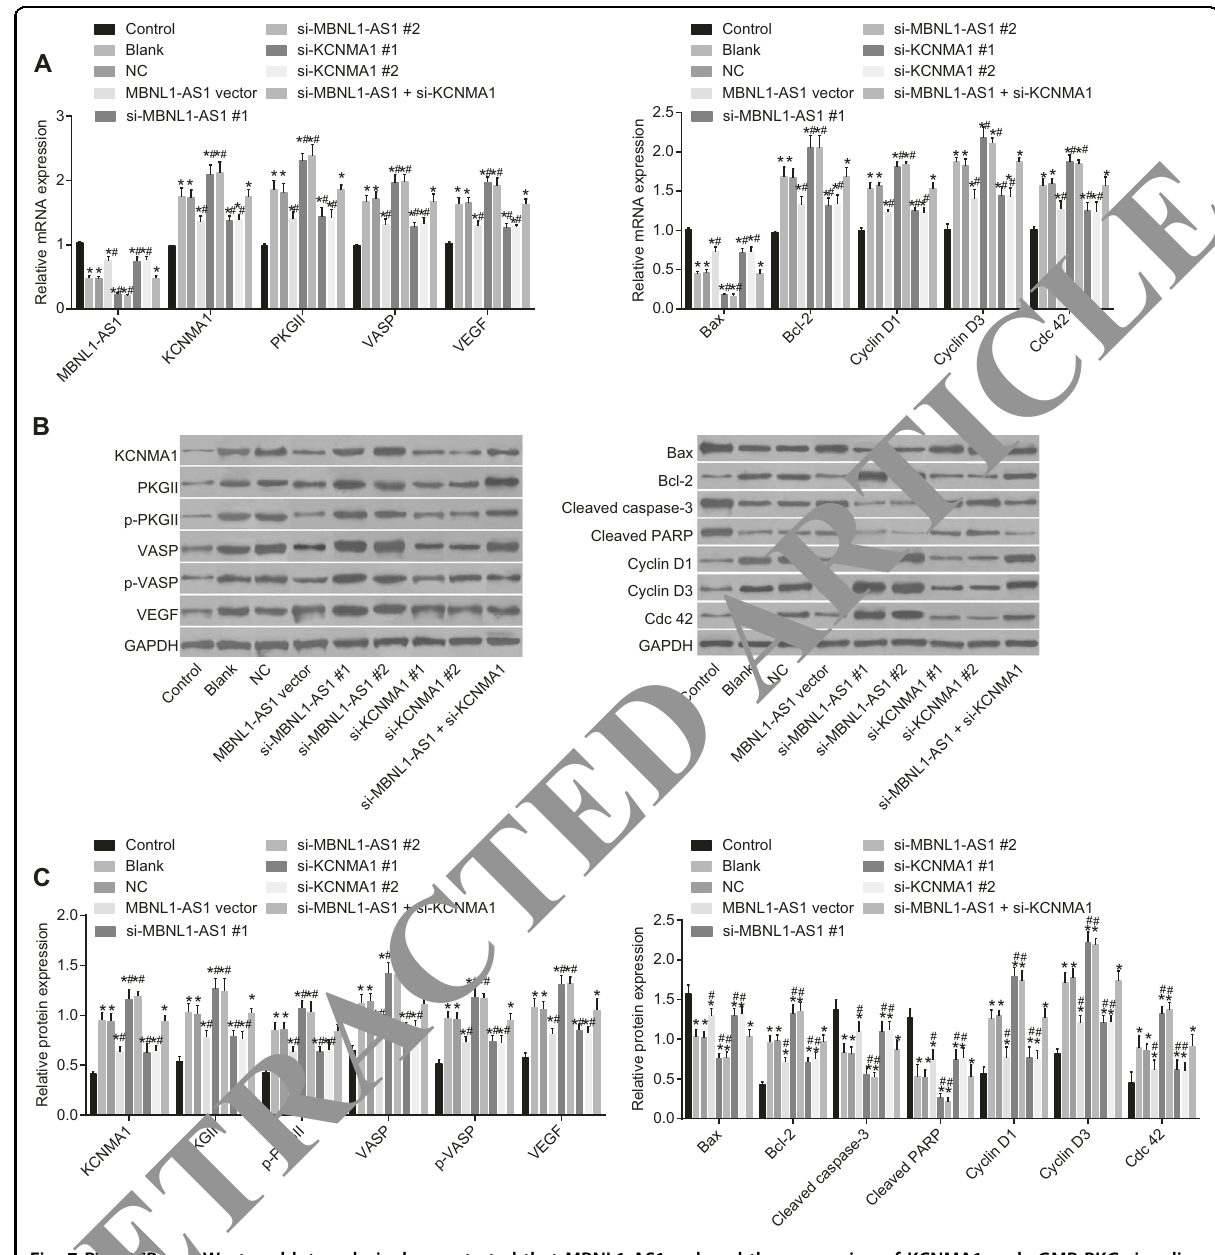
Fig. 7 RT-qPCR and Western blot analysis demonstrated that MBNL1-AS1 reduced the expression of KCNMA1 and cGMP-PKG signaling pathway-related genes. a RT-qPCR measured the relative mRNA expression of MBNL1-AS1, KCNMA1, PKGII, VASP, VEGF, Bax, and Bcl-2 in skeletal muscle cells after transfection. b Protein bands measured by Western blot analysis. c Western blot analysis measured the relative protein levels of KCNMA1, PKGII, VASP, p-PKGII, p-VASP, VEGF, Bax, and Bcl-2 in skeletal muscle cells after transfection. MBNL1-AS1 muscleblind-like 1 antisense RNA 1, KCNMA1 potassium calcium-activated channel subfamily M alpha 1, PKGII type II cyclic guanosine monophosphate-dependent protein kinase G, p- PKGII phosphorylated-PKGII, VASP vasodilator-stimulated phosphoprotein, p-VASP phosphorylated-VASP, VEGF vascular endothelial growth factor,